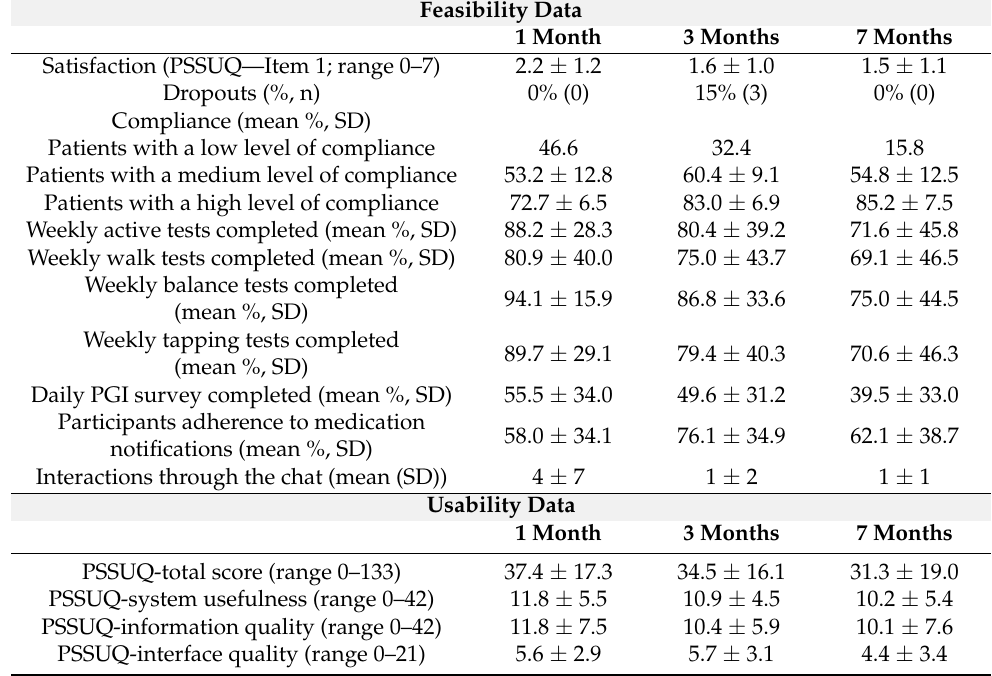
Table 3. Data from follow-up assessments. * Arbitrary